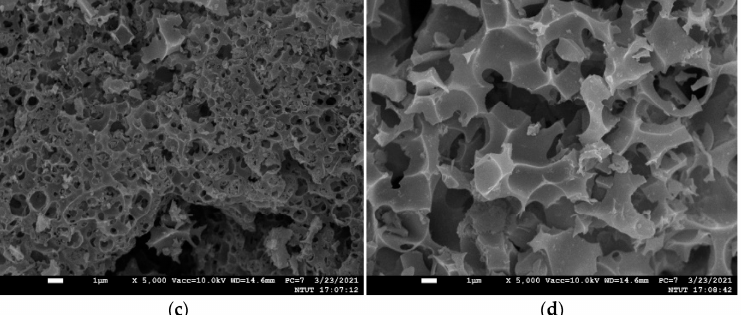
Figure 2. SEM micrographs of coconut-shell derived carbons without KOH ( a ) and at different KOH